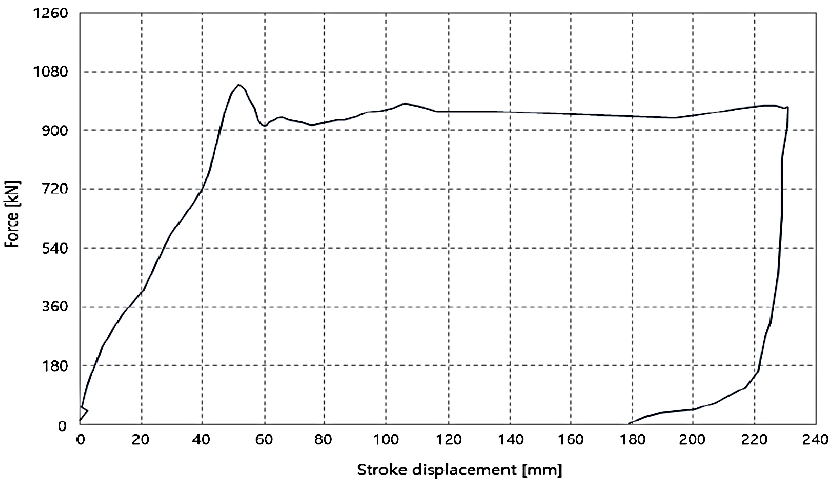
Figure 14. Curve of the intermediate coupler in collision test.